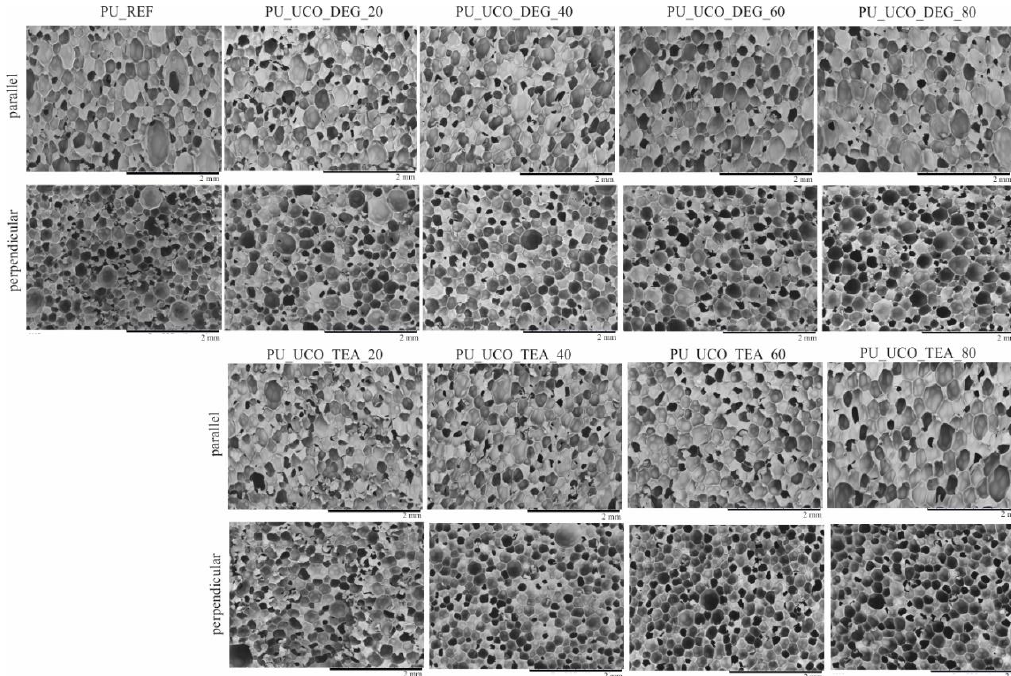
Figure 5. SEM images of polyurethane foams. Table 3. Characteristic properties of cellular structure of PUR foams.